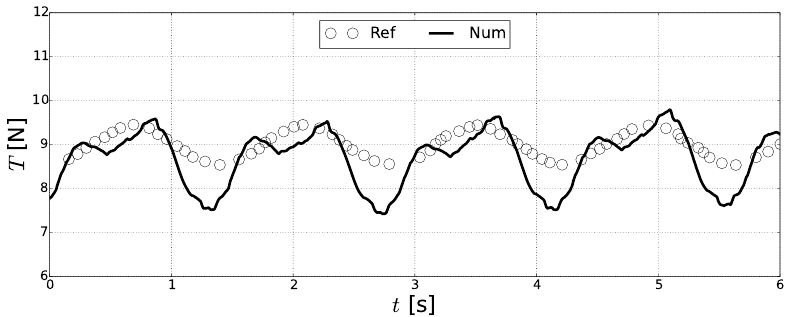
Figure 24. Numerical solution for the tension force magnitudes at the fairlead of the front mooring line over time with regular waves. The numerical reference solution was taken from